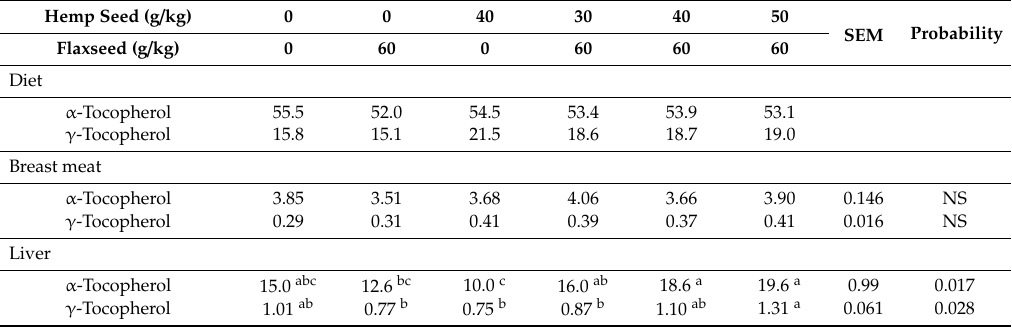
Table 5. Concentration of α -tocopherol and γ -tocopherol in the diets, breast meat and liver (mg / kg). Hemp Seed (g / kg)